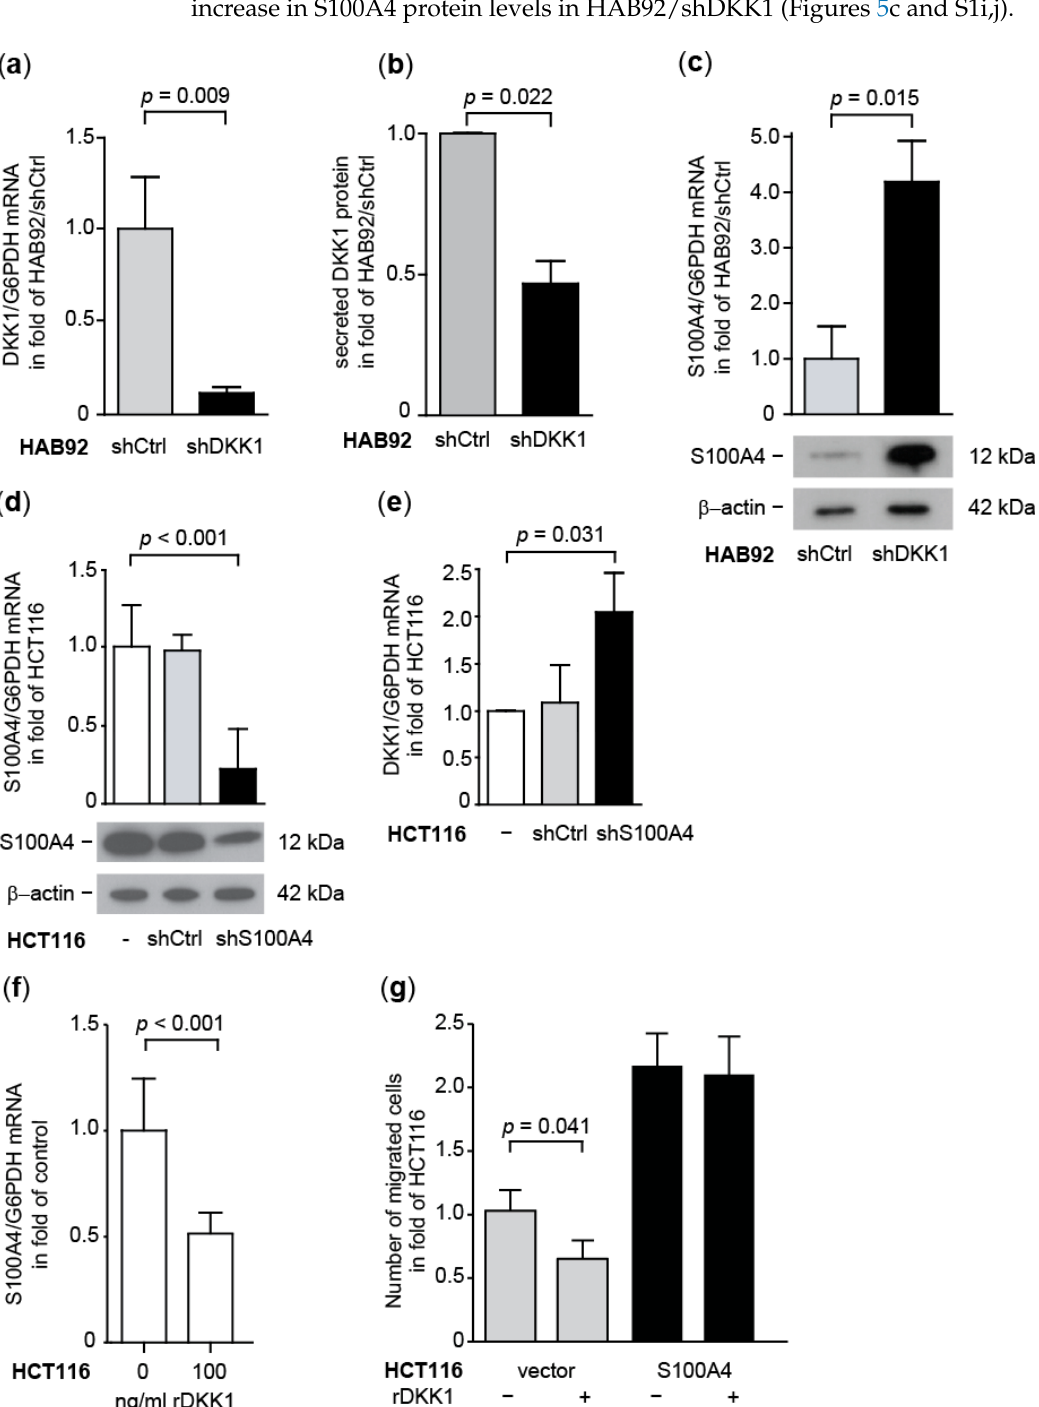
Figure 5. Transcriptional cross-regulation of DKK1 and S100A4 affects cellular motility. Relative DKK1 mRNA expression ( a ) and DKK1 protein secretion ( b ) in HAB92/shDKK1 cells. ( c ) Increase of S100A4 mRNA and protein expression in HAB92/shDKK1 cells. ( d ) Relative S100A4 mRNA and protein expression in HCT116/shS100A4 cells. ( e ) Increase of relative DKK1 mRNA expression in HCT116/shS100A4 cells. ( f ) Decrease of S100A4 mRNA expression level following treatment with rDKK1. ( g ) Decrease of cellular motility by rDKK1 treatment in HCT/vector cells is rescued by ectopic S100A4 expression in HCT116/S100A4